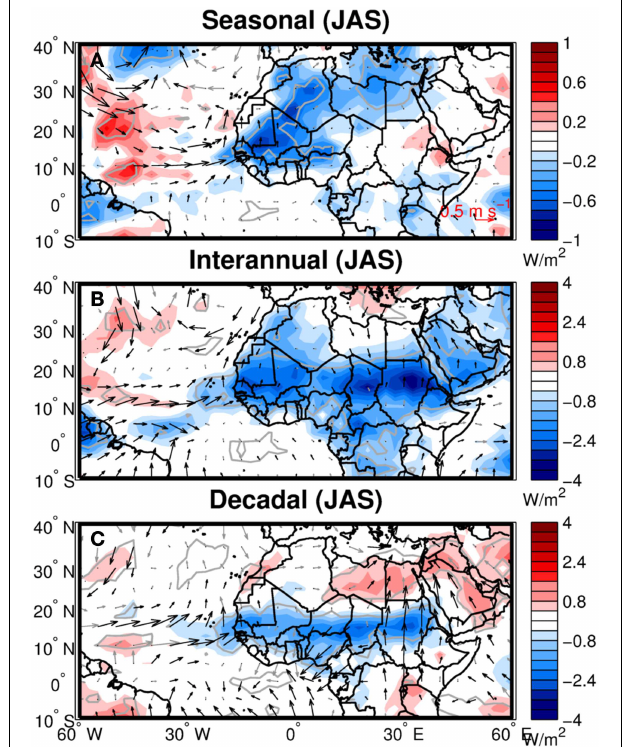
FIGURE 6 | Regression maps in summer (JAS) between Saloum rainfall and OLR (shaded, W/m 2 ) and surface winds (vectors, m/s) for: (A) Seasonal, (B) Interannual, and (C) Decadal time scale. Gray contours delimit areas where the regression is significant at the 95% significance level using a Monte Carlo